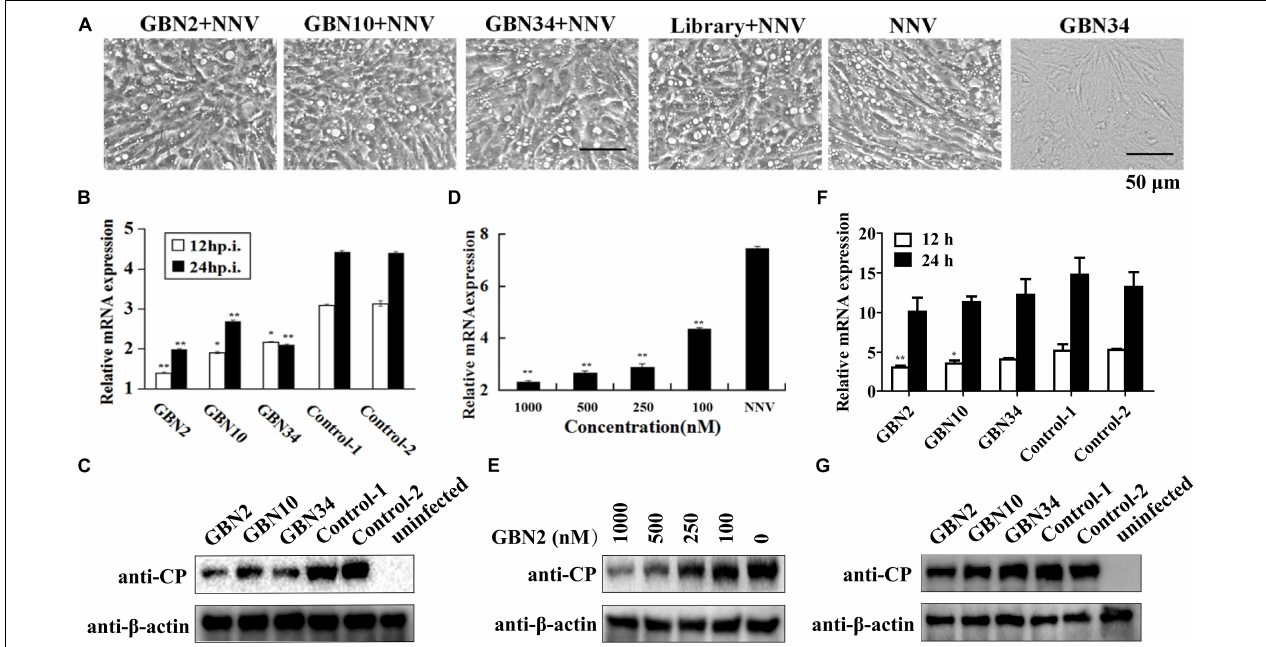
FIGURE 4 | Inhibition of RGNNV infection by selected aptamers in vitro . (A) Cell morphology and cytopathic effects (vacuolation) after infection with RGNNV, with or without added aptamer. (B,C) Relative CP mRNA expression (B) and CP level (C) were measured to determine the antiviral activity of the aptamer in cultured GB cells. (D,E) Aptamers inhibited RGNNV infection in a dose-dependent manner showed by relative CP mRNA expression (D) and CP level (E) . (F,G) Relative CP mRNA expression (F) and CP level (G) was determined to assess the curative effect of the aptamers in cultured GB cells. (** P < 0.01; * P < 0.05).